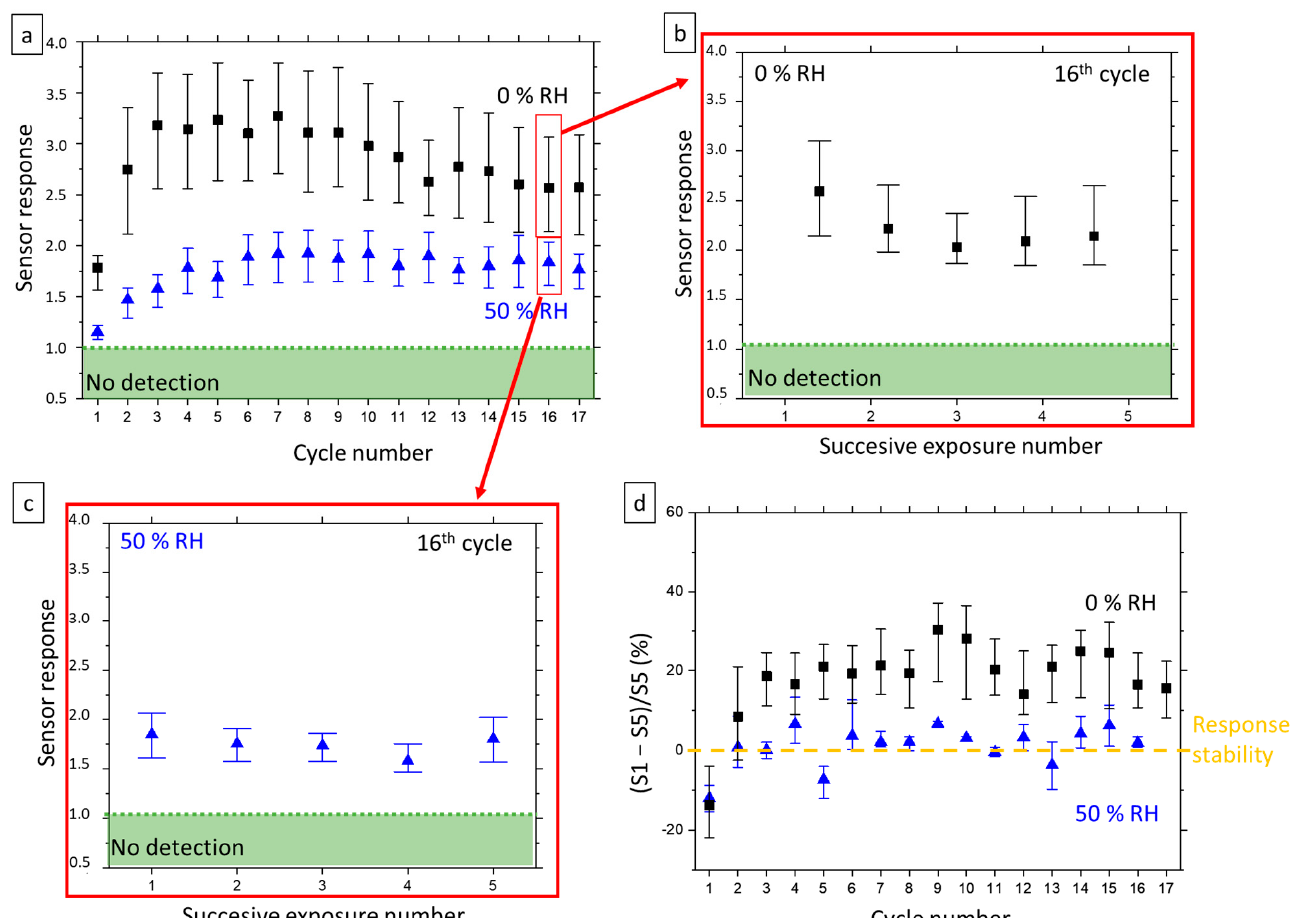
Figure 3. Evolution of D Low devices response in “Humidity Study” ( a ) for the first exposure to 2ppm of acetone under dry and 50% RH humid atmosphere for the whole study, ( b ) during the 16th exposure cycle under dry atmosphere and ( c ) during the 16th exposure cycle under 50% RH. ( d ) Relative loss of sensor response between the first (S1) and the fifth (S5) successive injection of acetone for all 17 gas exposure cycles in “Humidity Study”. Black squares refer to results in dry atmosphere and blue triangle in humid atmosphere. The symbol represents the mean response calculated from 4 devices and the upper and lower lines represent respectfully the value of higher and lower responses obtained. Dashed line in panel (d) refers to stability of the response towards successive injections of acetone. Red rectangles in Figure 2a represent the 16th cycle which is detailed in Figure 2b,c. Data for I Low loss of response are presented in Appendix C (Figure A3).